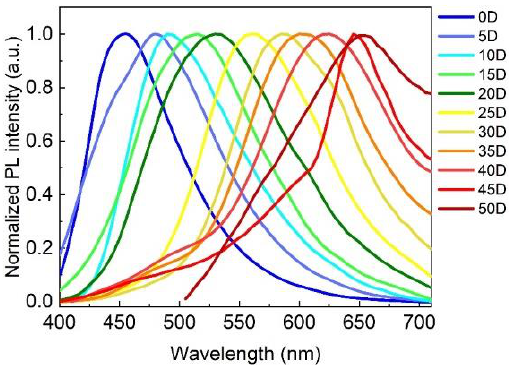
Figure 2. PL spectra of the as-prepared samples that were synthesized by changing the solvent volume ratio between the H 2 O and DMF.